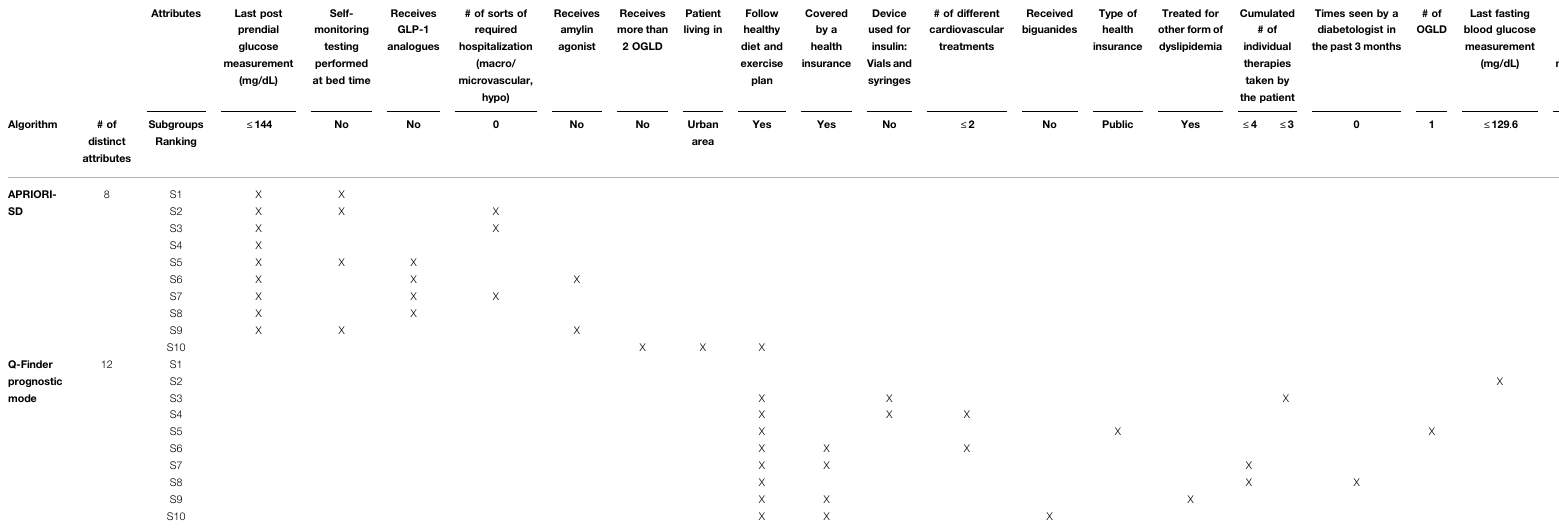
TABLE 7 | Prognostic subgroup diversity visualization per attribute and selector-value pairs. Attributes